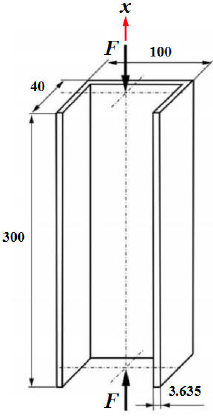
Figure 23: Laminated compression column with a single-channel cross section (unit: mm).